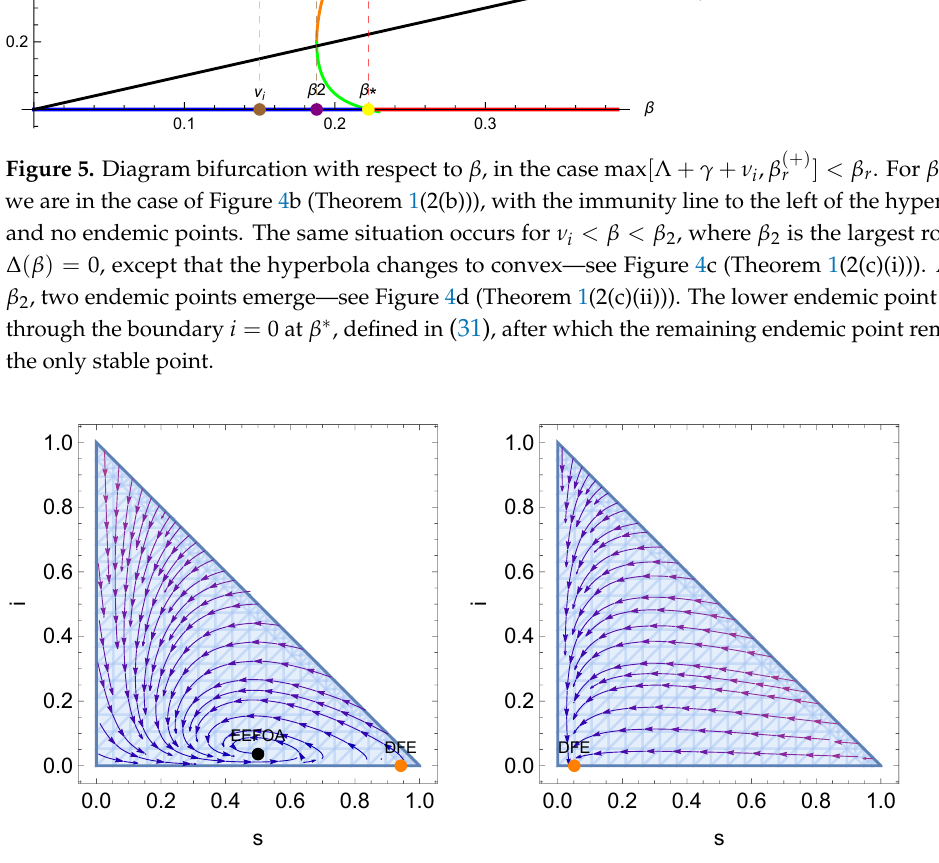
Figure 6. Stream plots of ( s , i ) for the FA model when γ s ∈ { 1/100,3 } is smaller and bigger, respectively, than the critical vaccination γ ∗ s = 0.239087 defined in (25)